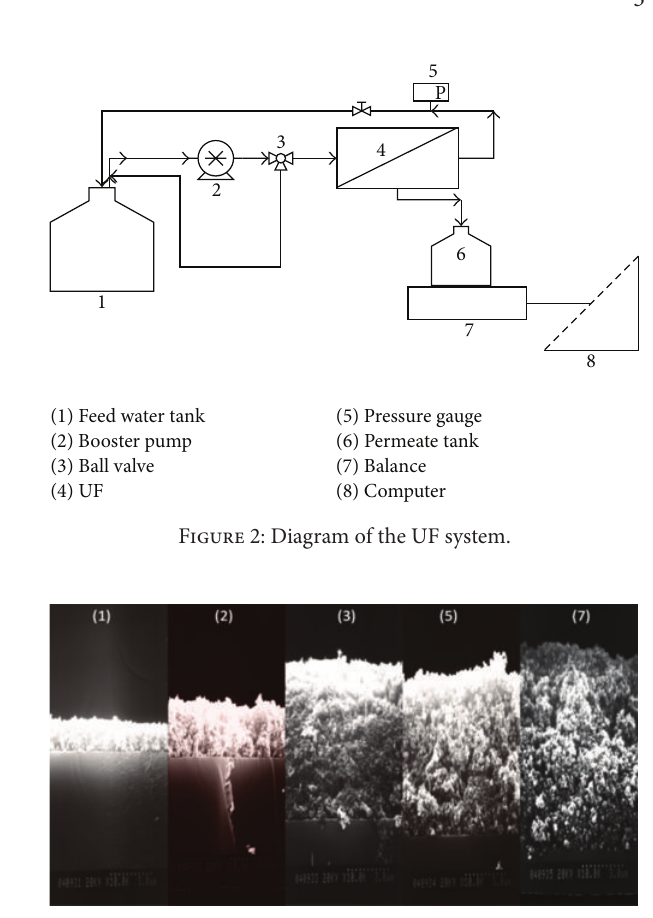
Figure 3: Corresponding film thicknesses after TiO 2 coating with 1, 2, 3, 5, and 7